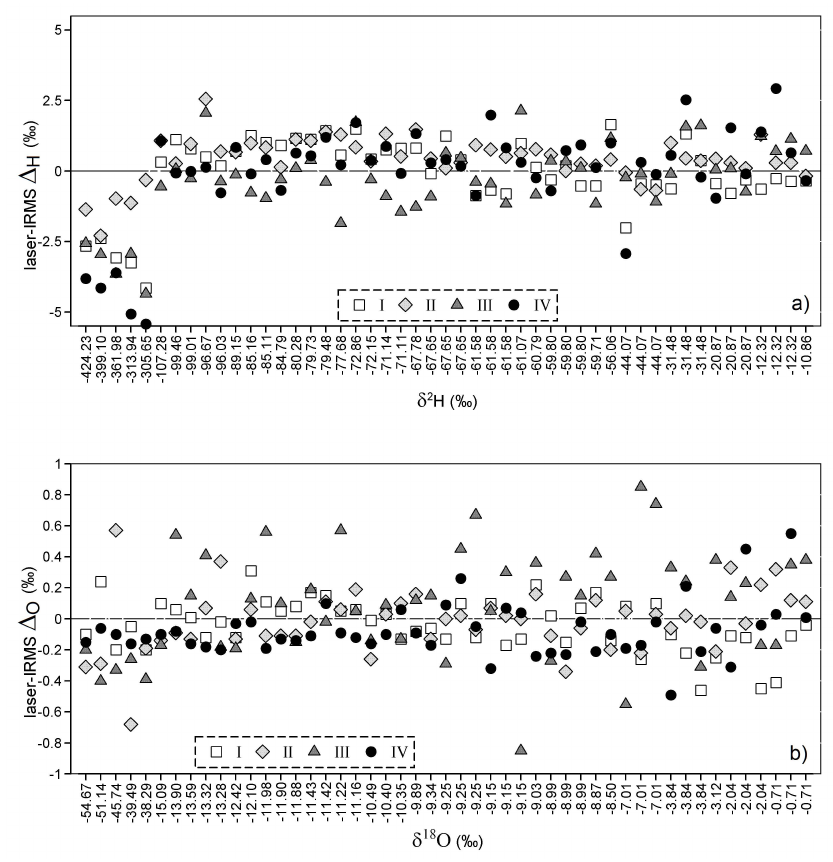
Fig. 4. δ 2 H (a) and δ 18 O (b) deviations for all datasets (A1 scheme). The horizontal line represents 0 value, i.e., no difference between laser spectroscope and mass spectrometer